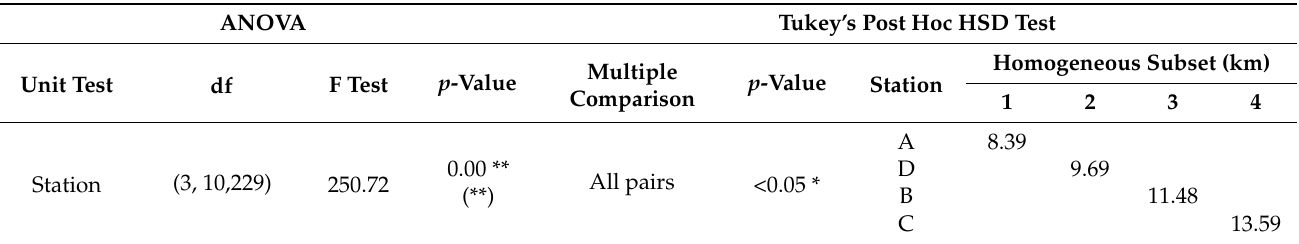
Table 3. Summary of ANOVA and Tukey’s post hoc HSD test for overall mean distance travelled.